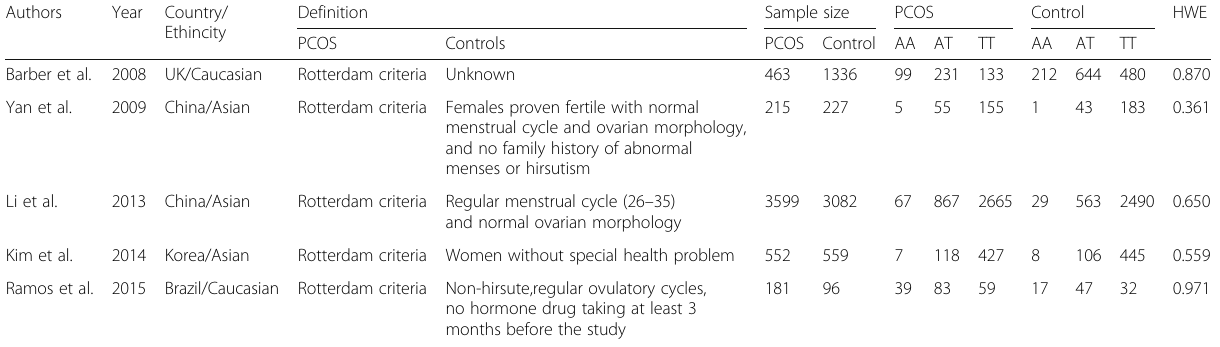
Table 1 Characteristics of included studies in this